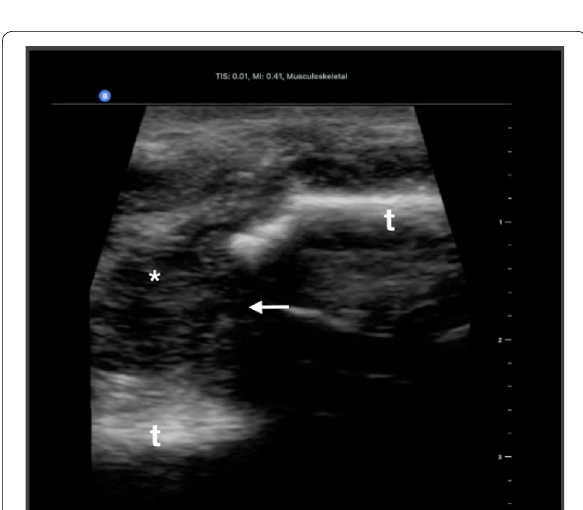
Fig. 3 Musculoskeletal ultrasound of a young male patient with blunt trauma demonstrating two separate sections of tibial cortex (t), with displacement (arrows). Note the associated fracture hematoma visualized (*) Table 3 Procedures guided by Butterfly iQ in an